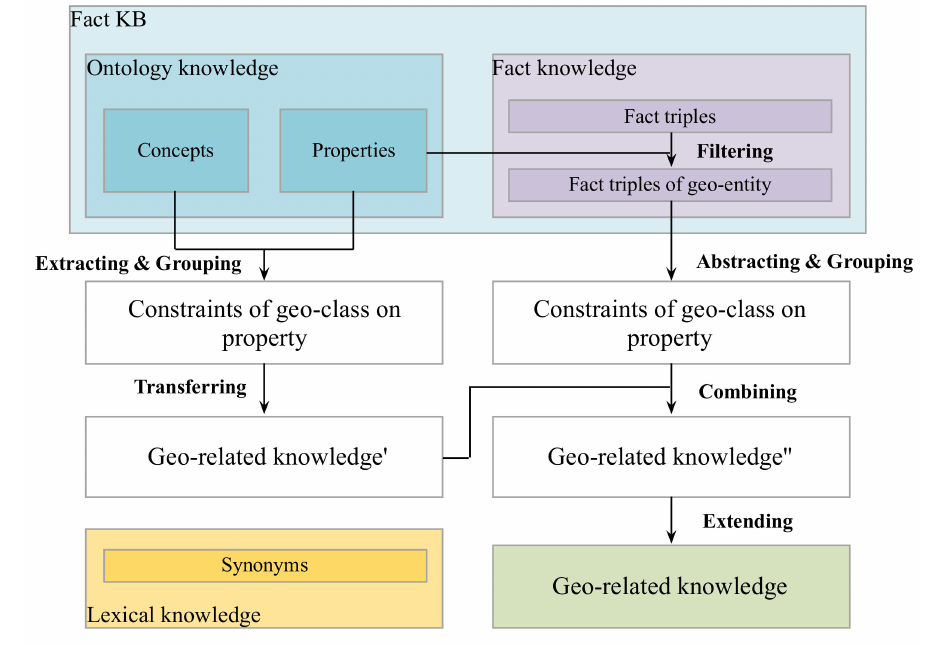
Figure 1. Flowchart for acquiring geo-related